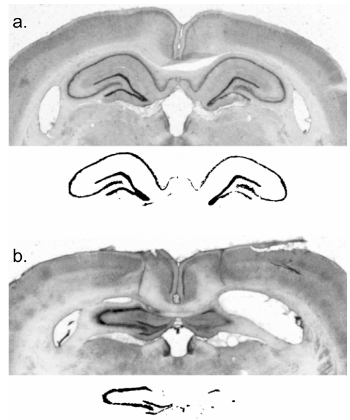
Figure 1. An index of lesion in each subject was obtained when digital images of the dorsal hippocampus were subjected to a grayscale threshold so that the area within the cell body layers of the surviving dorsal hippocampus was calculated. ( a ) Grayscale and thresholded images of a control subject; ( b ) images of a lesioned subject.